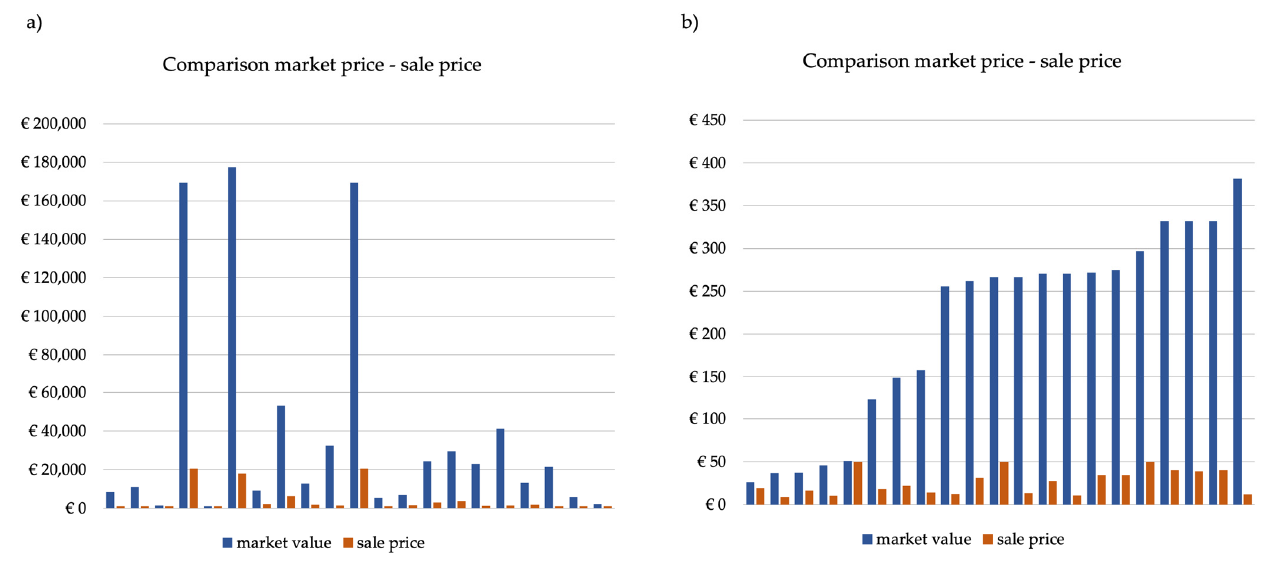
Figure 8. Gap between market value and sale price: ( a ) total values (EUR); ( b ) unit values (EUR/sq.m).